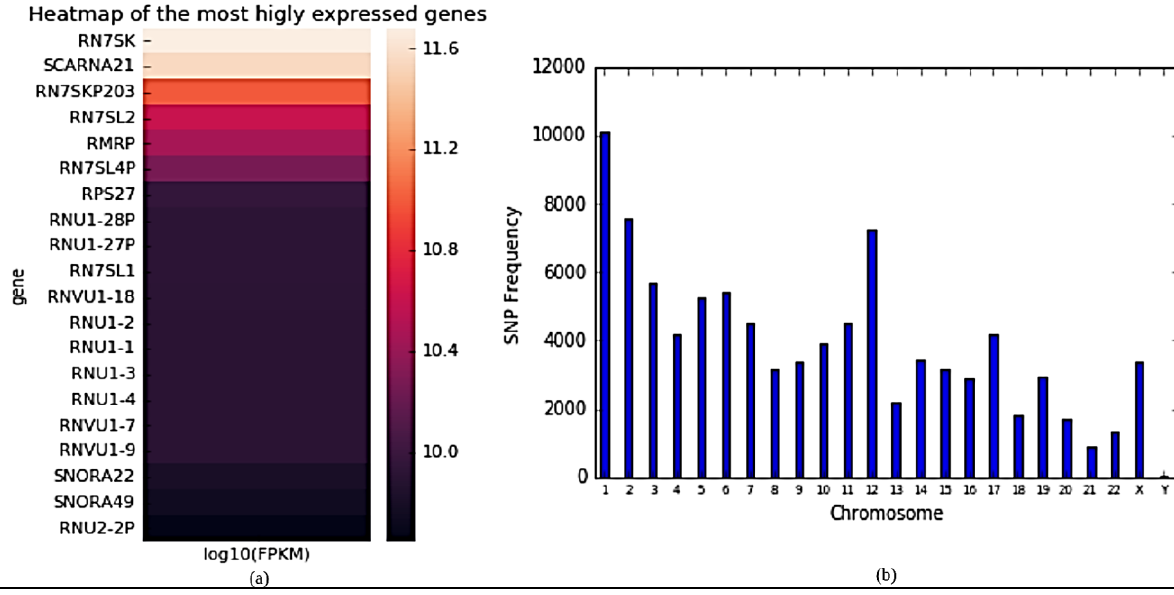
Figure 5. RNAseq analysis results intra-person visualization: (a) the 20 most highly expressed genes in a patient (b) the distribution of SNPs per chromosome as they were computed via this